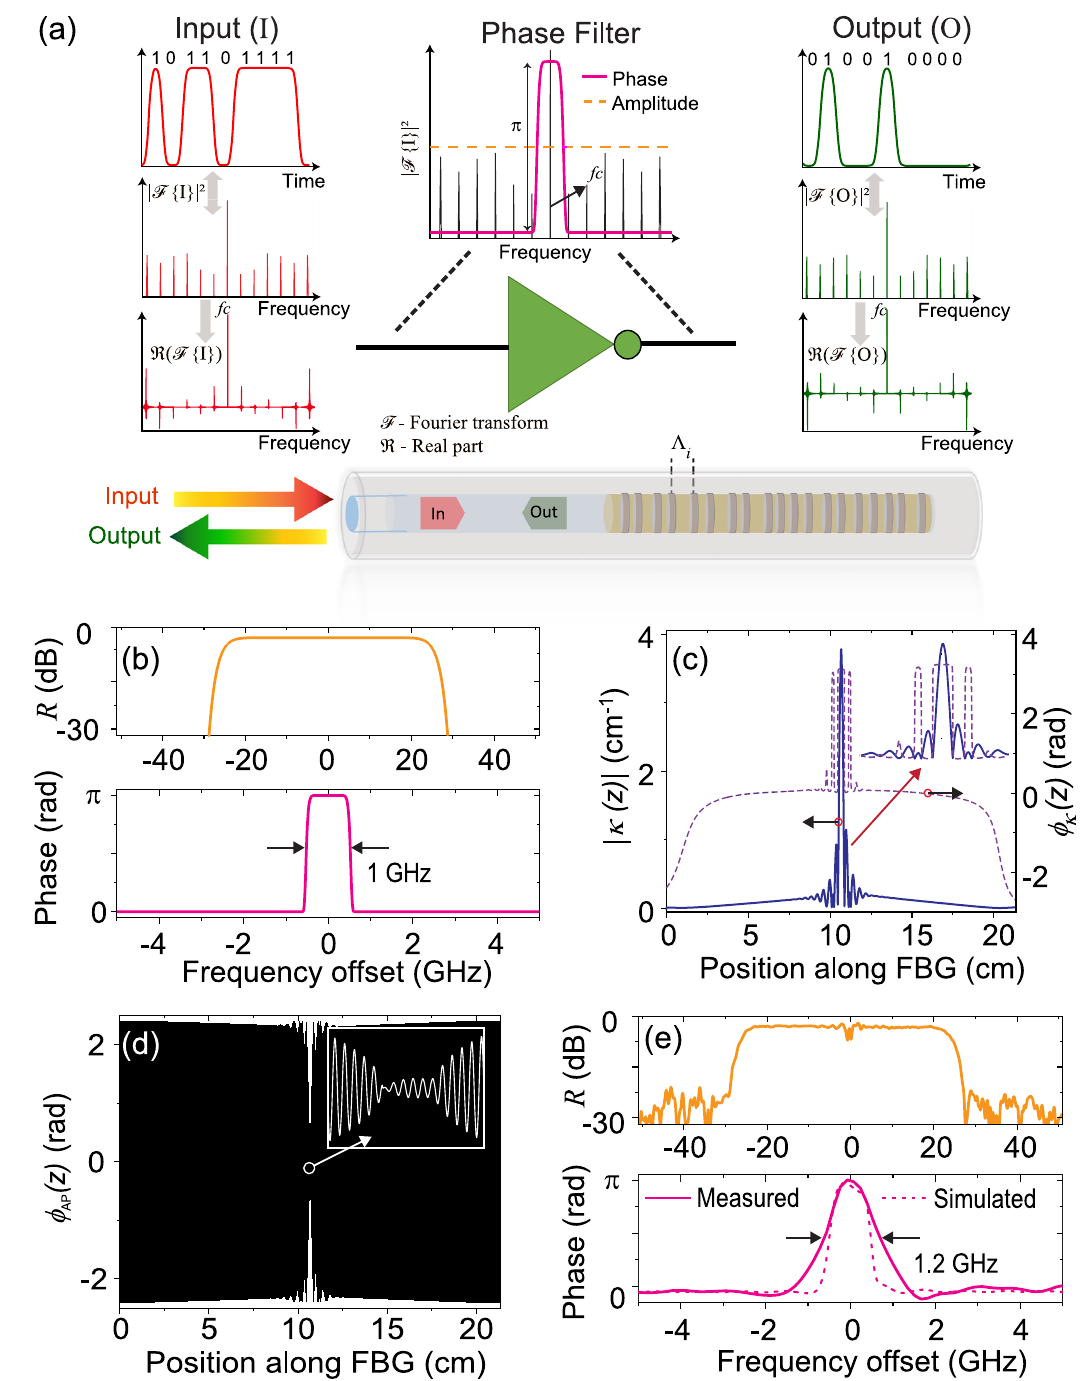
Fig.1|A fi breBragggrating-basedlinearpassiveNOTgateforhigh-speedNRZ- OOK signals.a A selective application ofa π − phase shifton the central or carrier frequency component, f c ensures inversion of the entire input datastreamat once in the time-domain 16 . This is possible as the spectrum ( ∣ F ð(cid:2)Þ ∣ 2 ) of both the input and the output-inverted data streams are identical, except for the reversal in the phase of the individual spectral components corresponding to the data bits, as seen in the real part of the spectrum, <ð F ð(cid:2)ÞÞ . A fi bre Bragg grating (FBG), oper- atinginre fl ection,isdesignedtorealizethephase-only fi lter.Thetargetresponseis realized by varying the separation, Λ i between individual grating planes along the FBG. b Targetedre fl ectivity, R (top),andthespectralphasepro fi le(bottom)ofthe FBG. c Required coupling coef fi cient pro fi le κ ( z )= ∣ κ ( z ) ∣ exp ( j ϕ κ ( z )) extracted by